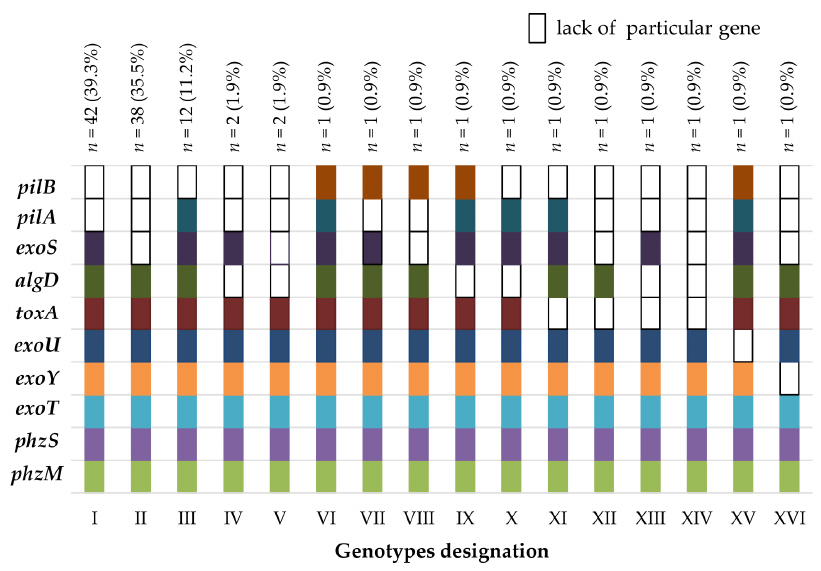
Figure 3. Genotypes’ distribution detected amongst the examined P. aeruginosa strains ( n = 107).